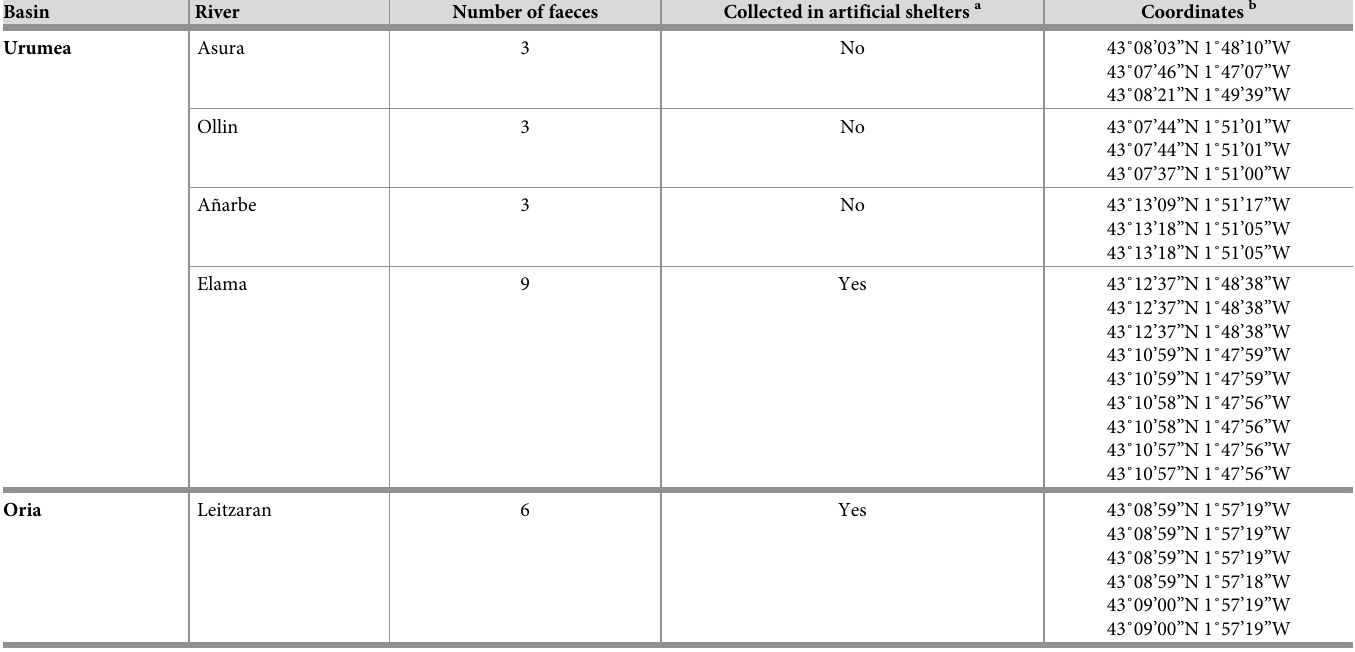
Table 1. Location of analysed faecal